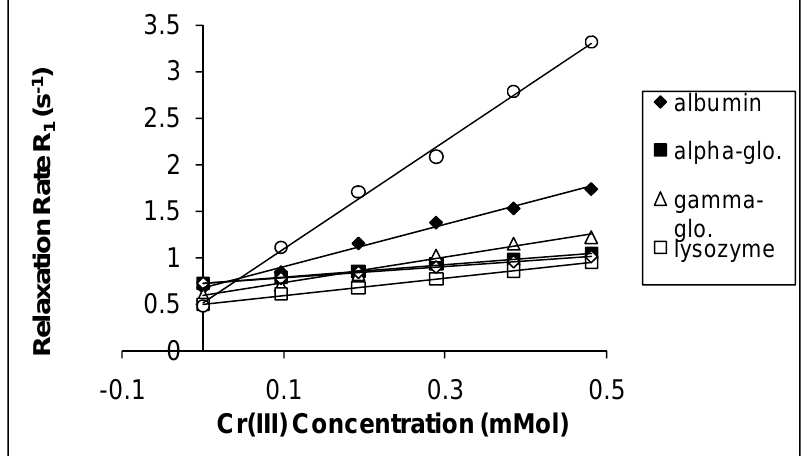
) of protein solutions versus concentration of Cr(III). 1